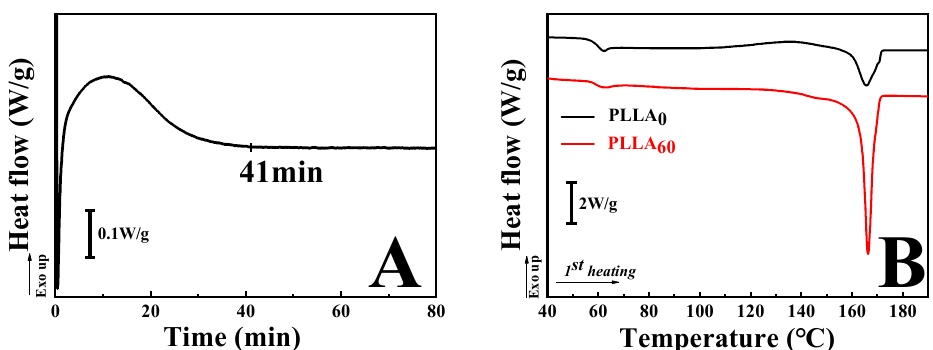
Figure 1. The crystallization kinetics of PLLA film at 120 ◦ C ( A ) and the first heating DSC curve of PLLA 0 and PLLA 60 ( B ).